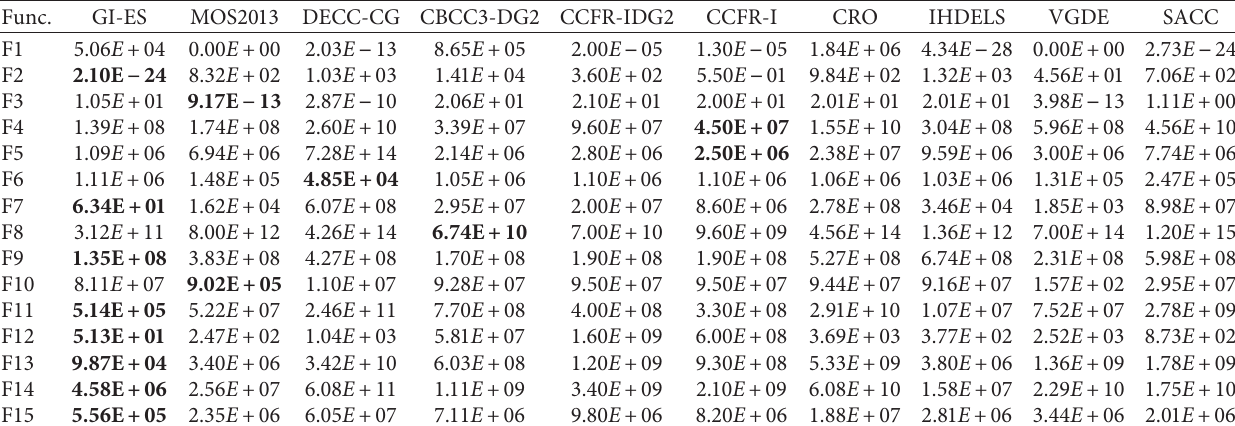
FE � 3.0 E +06, bold font represents the best result.